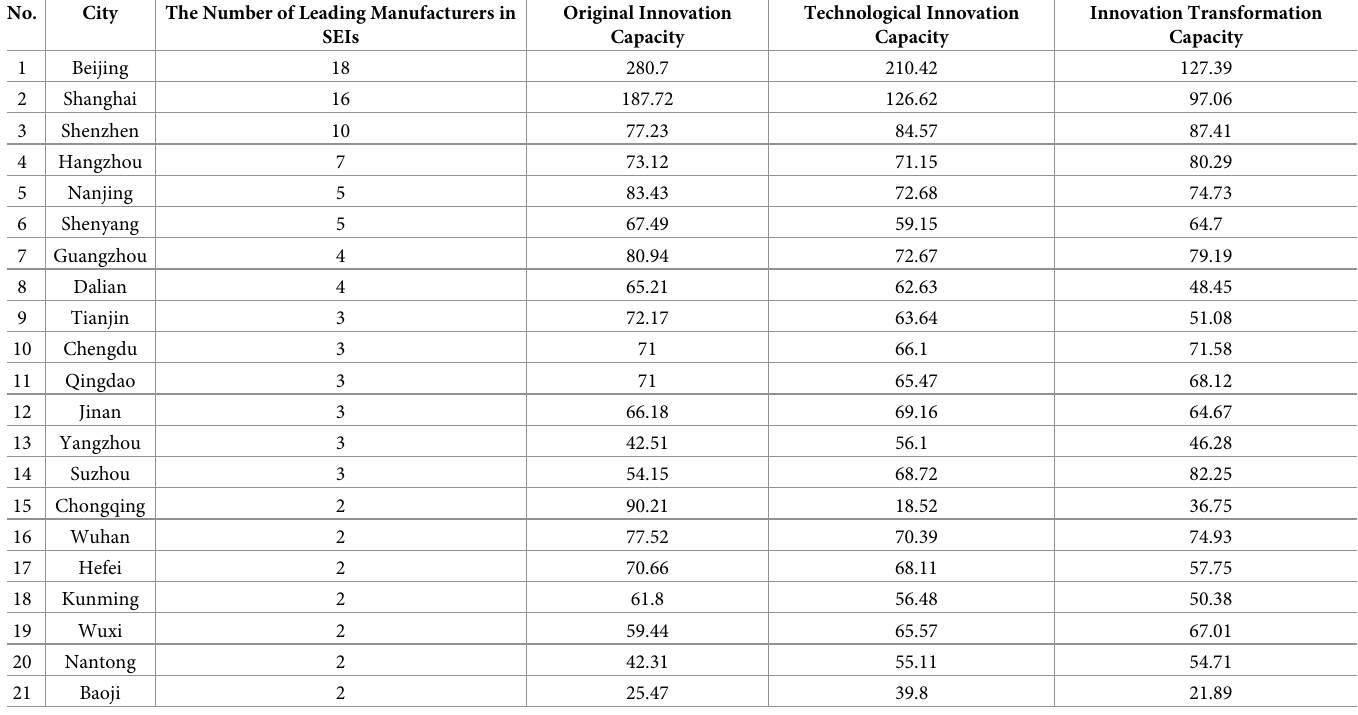
Table 2. Three capabilities data of UICs and the number of leading manufacturers in SEIs.